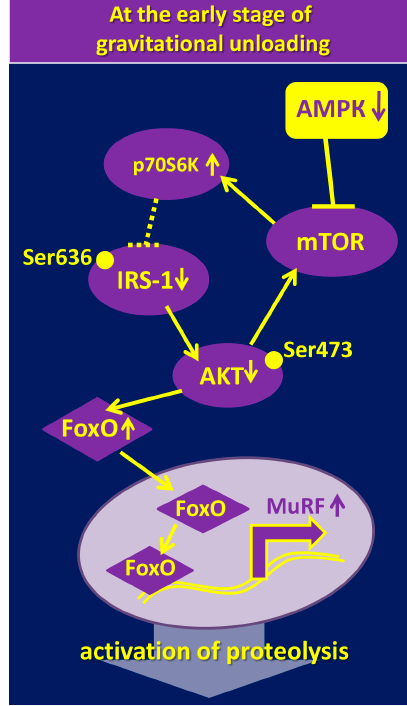
Figure 2. Hypothetical role of AMPK in the activation of signaling pathways regulating the expression of E3-ubiquitin ligases during gravitational unloading.